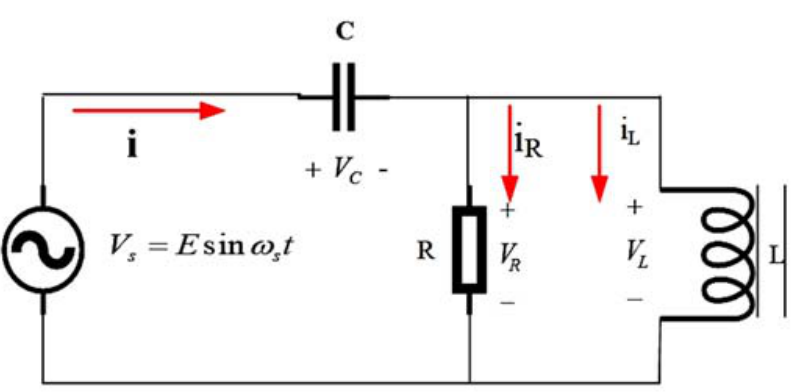
Figure 3. The equivalent circuit of the transformer for ferroresonance analysis.